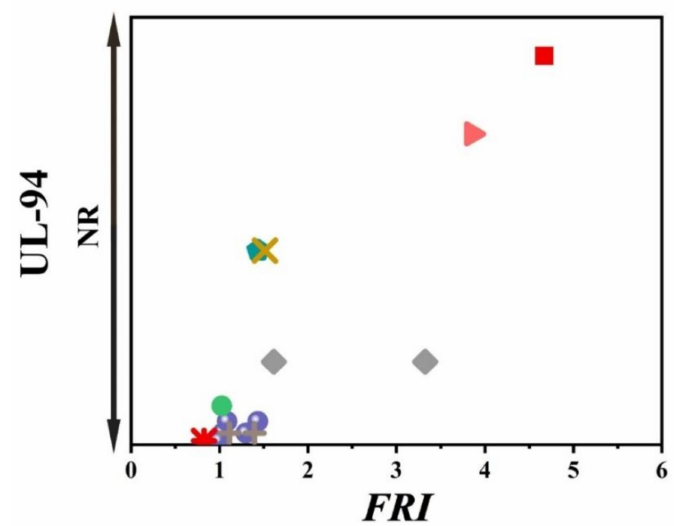
Figure 8. FRI values versus UL-94 test results. Symbols are indicative of di ff erent types of mineral flame retardant (FR) used. The vertical intervals in each category, i.e., V-0, V-1, V-2, and NR, are schematically representative of the amount of additive used. For example, two data distinguished by di ff erent symbols having the same or very close FRI values (horizontal quantity) in a given category (e.g., V-1), may have di ff erent vertical quantities, e.g., both reveal V-1 behavior in UL-94 test, but the upper contains more FR in PP.